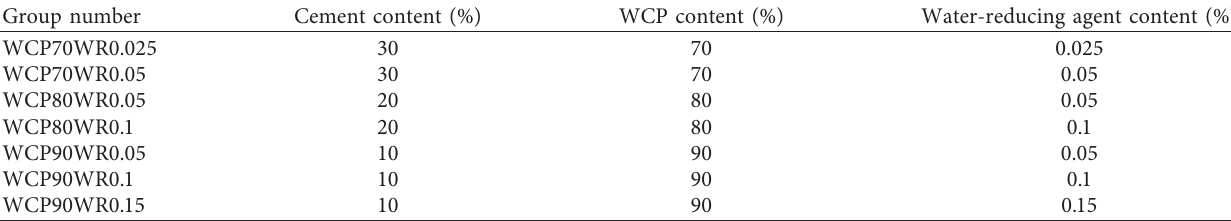
Table 3: Test ratios of phase 2.